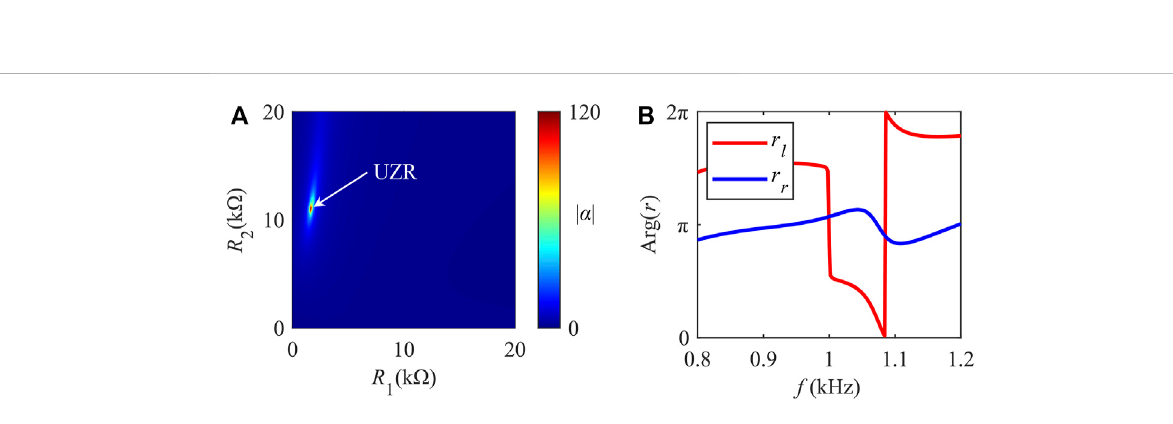
(cid:2) R (cid:2) 100 Ω , and (C) case 3: R 1 2